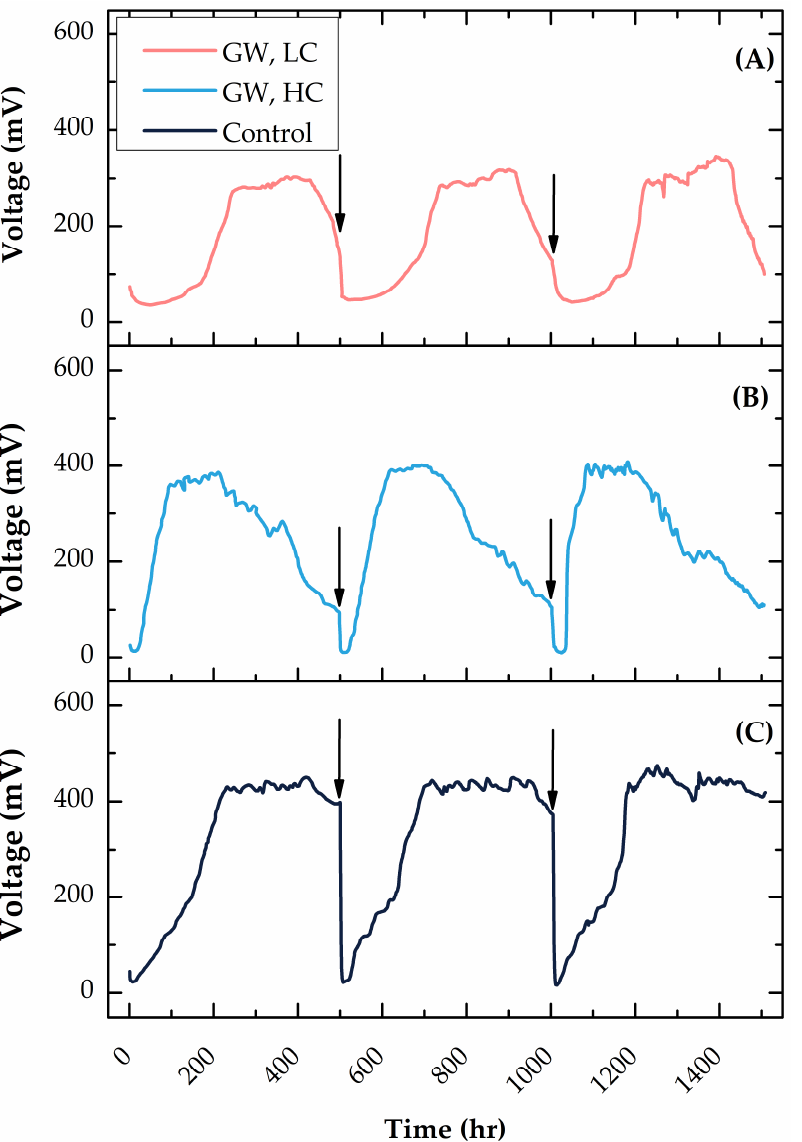
Figure 3. Voltage trend in the different tests. ( A ) GW, LC: greywater, low conductivity; ( B ) GW, HC: greywater, high conductivity; ( C ) Control: control test with acetate. Vertical black arrows represent the refresh of the MFC’s medium at the end of a batch prior to the following.